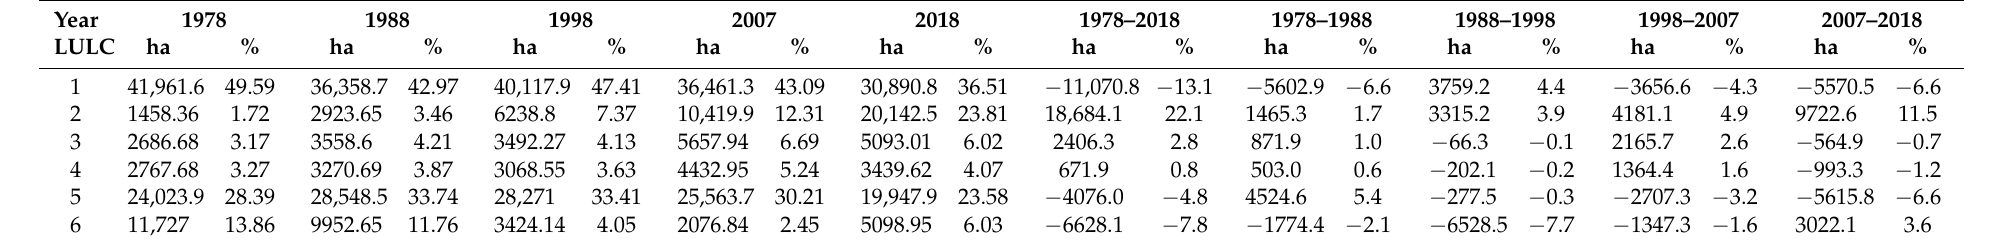
Table 7. Decadal LULC classes area (ha) and percentage (%) distribution along with the change matrix for the catchment